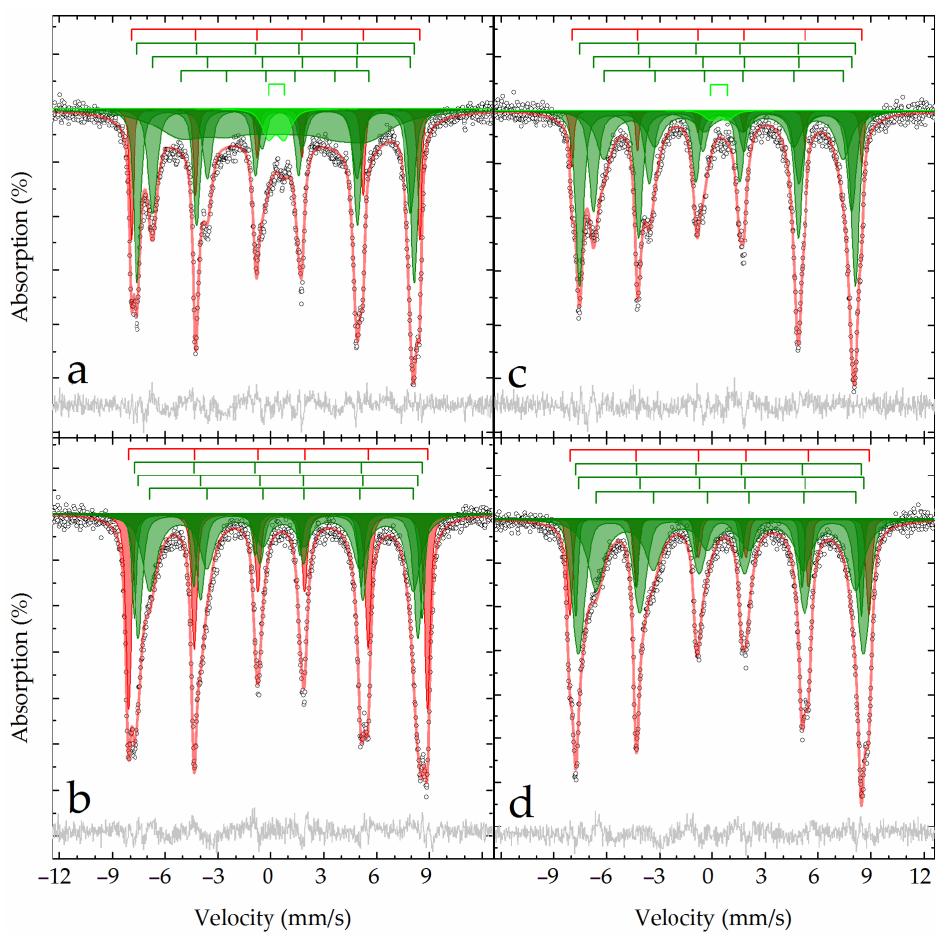
Figure 10. Mössbauer spectra of the BR residue ( a , b ) and sands residue ( c , d ) samples obtained at 296 K ( a , c ) and 77.6 K ( b , d ) and their model description according to Table 6. The hyperfine parameters of the minor doublet observed only at room temperature correspond to Fe 3+ ions in an octahedral oxygen environment